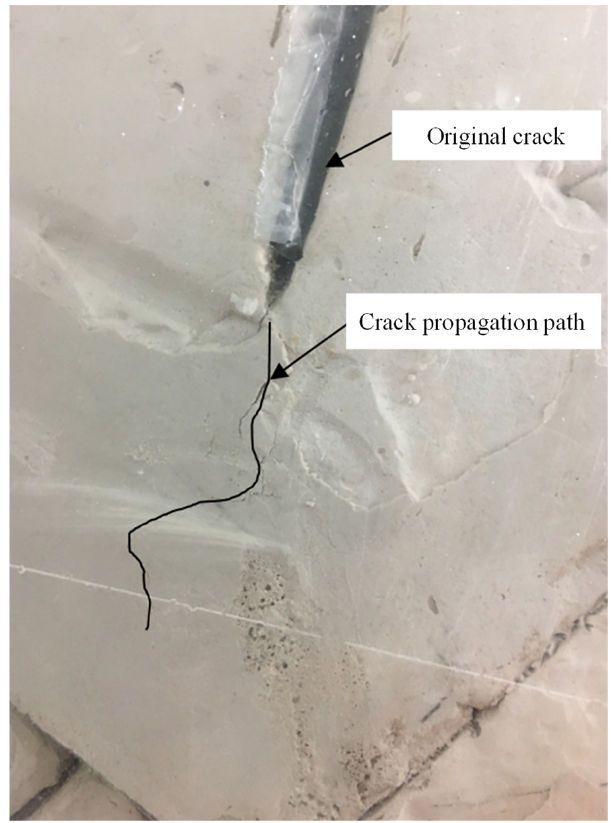
Figure 8. Cracks caused by the freeze–thaw effect and their propagation paths.